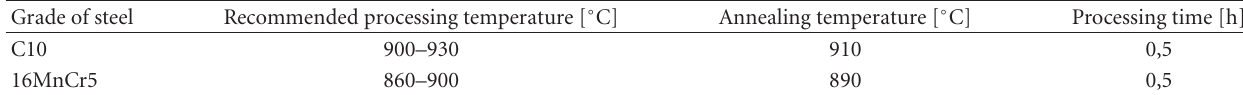
Table 2: The parameters of